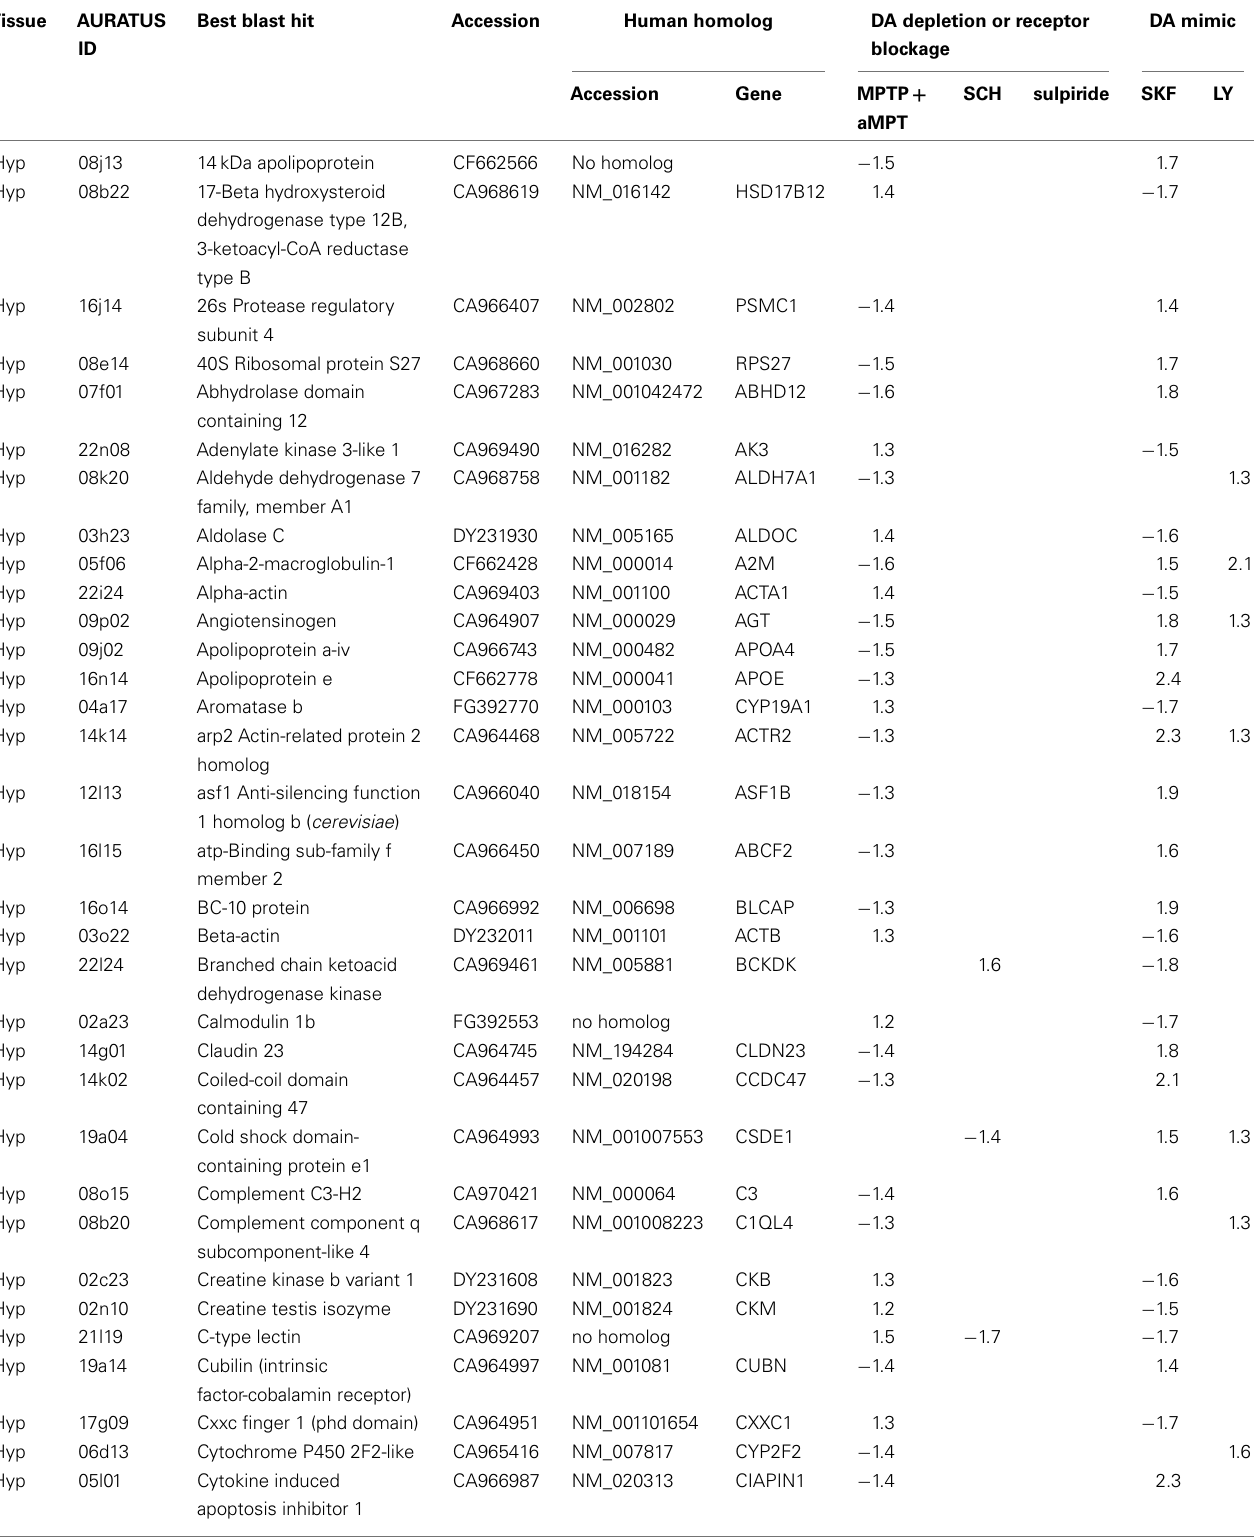
Table 2 | Genes/ESTs identified as regulated by dopamine, presented as fold-changes. Tissue